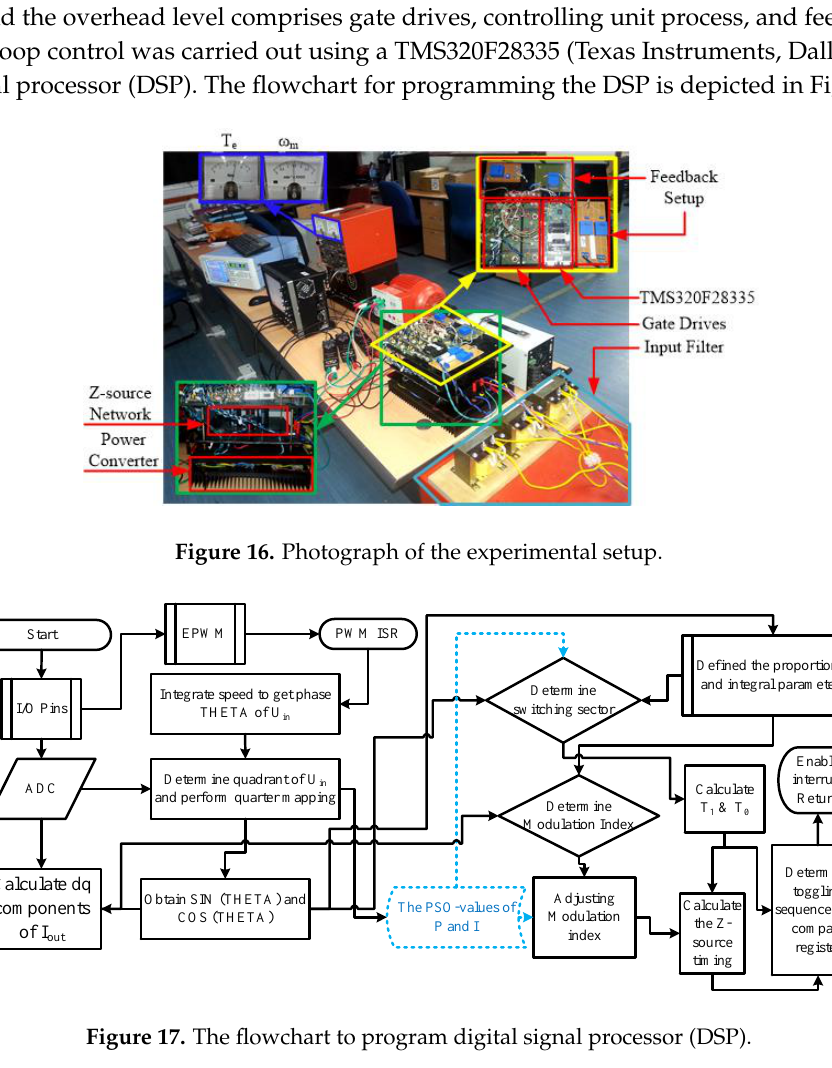
200 V Figure 18. Steady-state performance ( a ) three phase abnormal input voltage; ( b ) input current after and before filter; and ( c ) voltage of U dc (after Z-source) and U i (before Z-source) at DC-link.